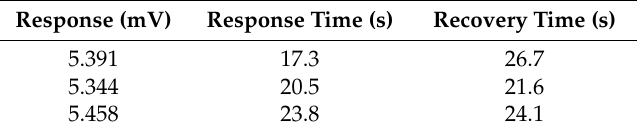
Figure 7. Repeatability test of the proposed SAW sensor at 30 ◦ C. Table 1. Sensor response towards for consecutive exposures to 20 ppm H 2